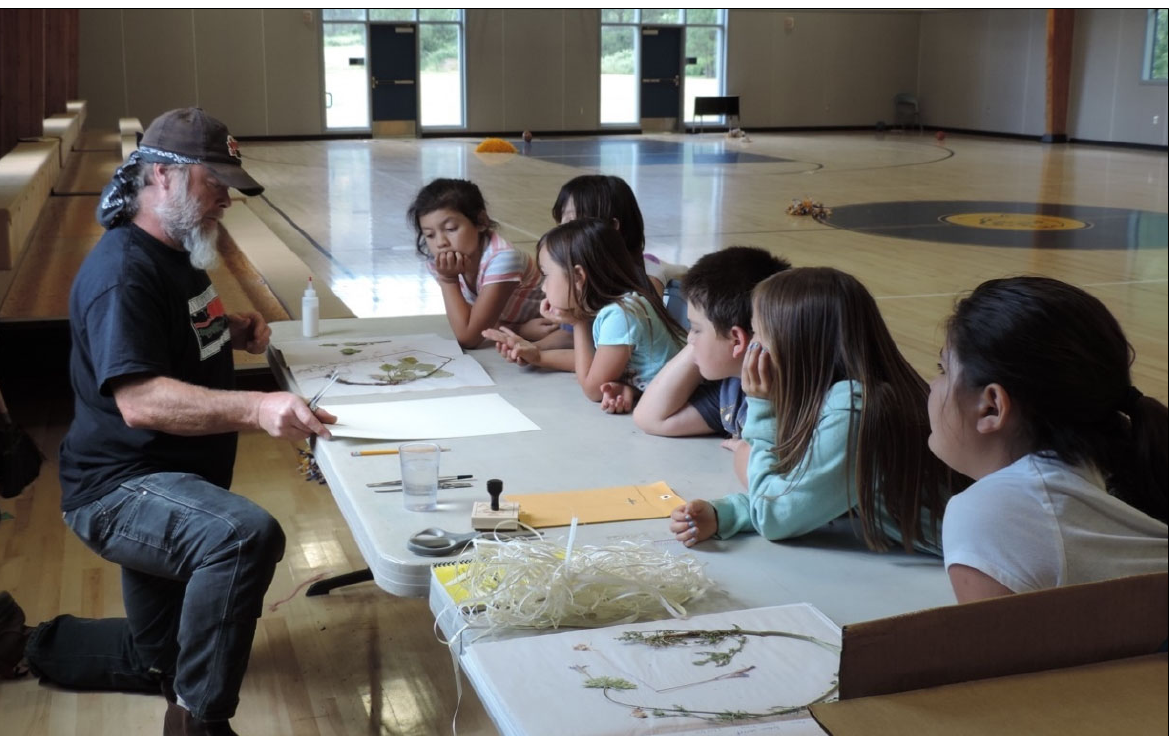
Figure 3. Youth in Orleans, California, Learning about Pressing and Mounting Herbarium Voucher Specimens for the Karuk